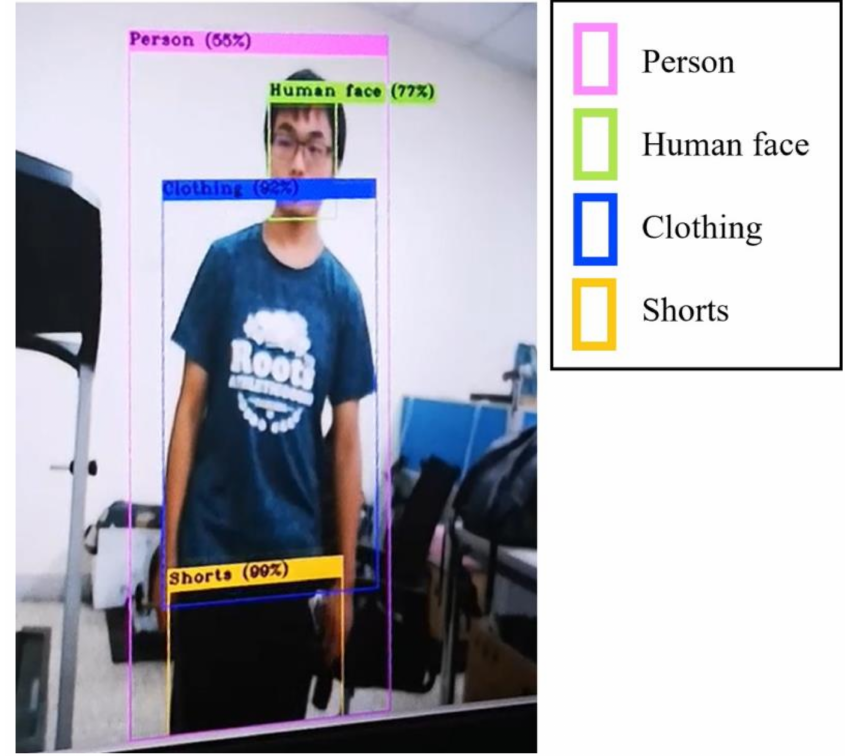
Figure 16. Demonstration of the locking the